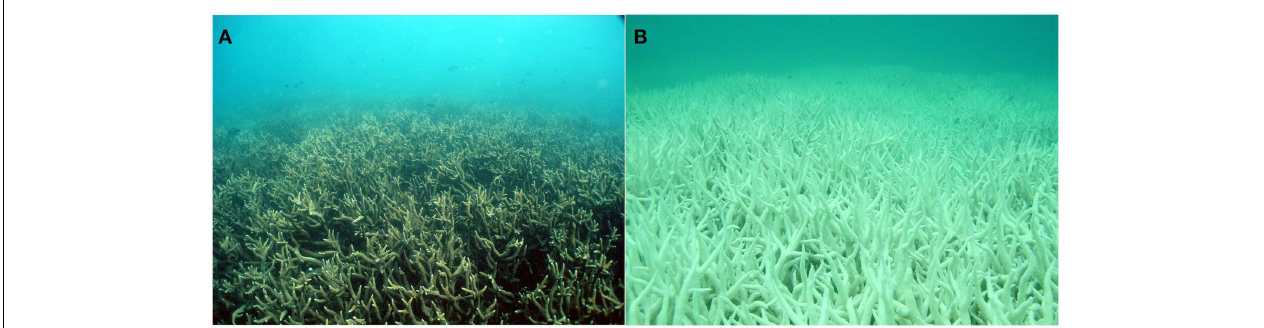
FIGURE 5 | The same coral community (A) before and (B) after a bleaching event in February 2002 at 5m depth, Halfway Island, Great Barrier Reef. Approximately 95% of the coral community was severely bleached in 2002. Source: Elvidge et al.